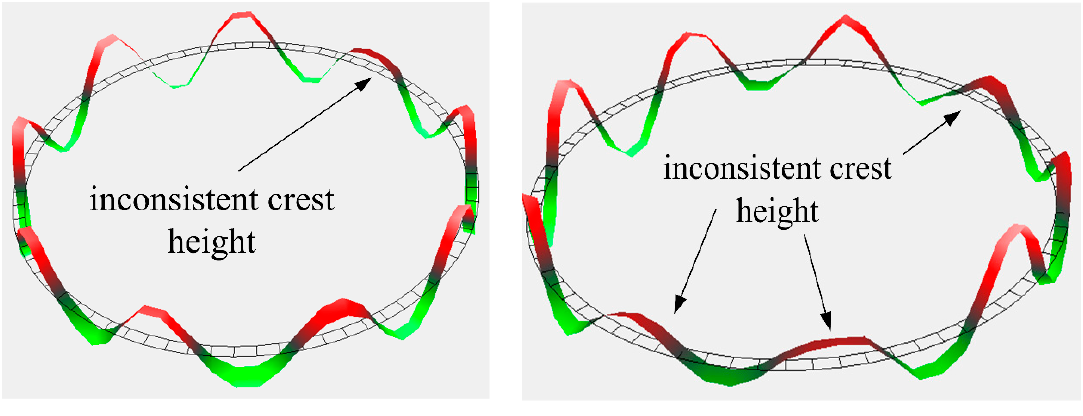
Figure 12. Vibration characteristic of stator 2.